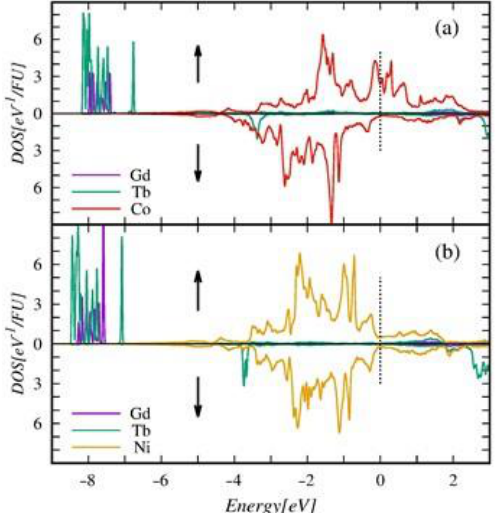
Figure 16. Spin resolved atomic contributions to the total density of states (DOS) calculated for end compounds: Gd 0.375 Tb 0.625 Co 2 —( a ) and Gd 0.375 Tb 0.625 Ni 2 —( b ). The energy scale zero is shifted to the Fermi level ε F (vertical dot lines). The arrows distinguish the spin orientations of electronic states.